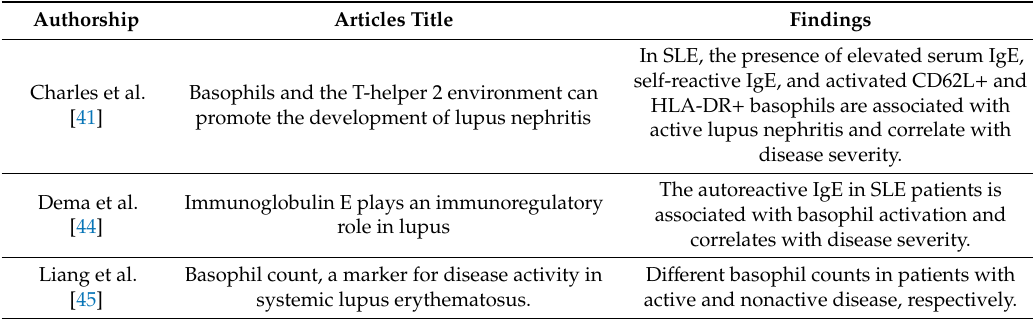
Table 2. Search output of human studies providing information on basophils in patients with